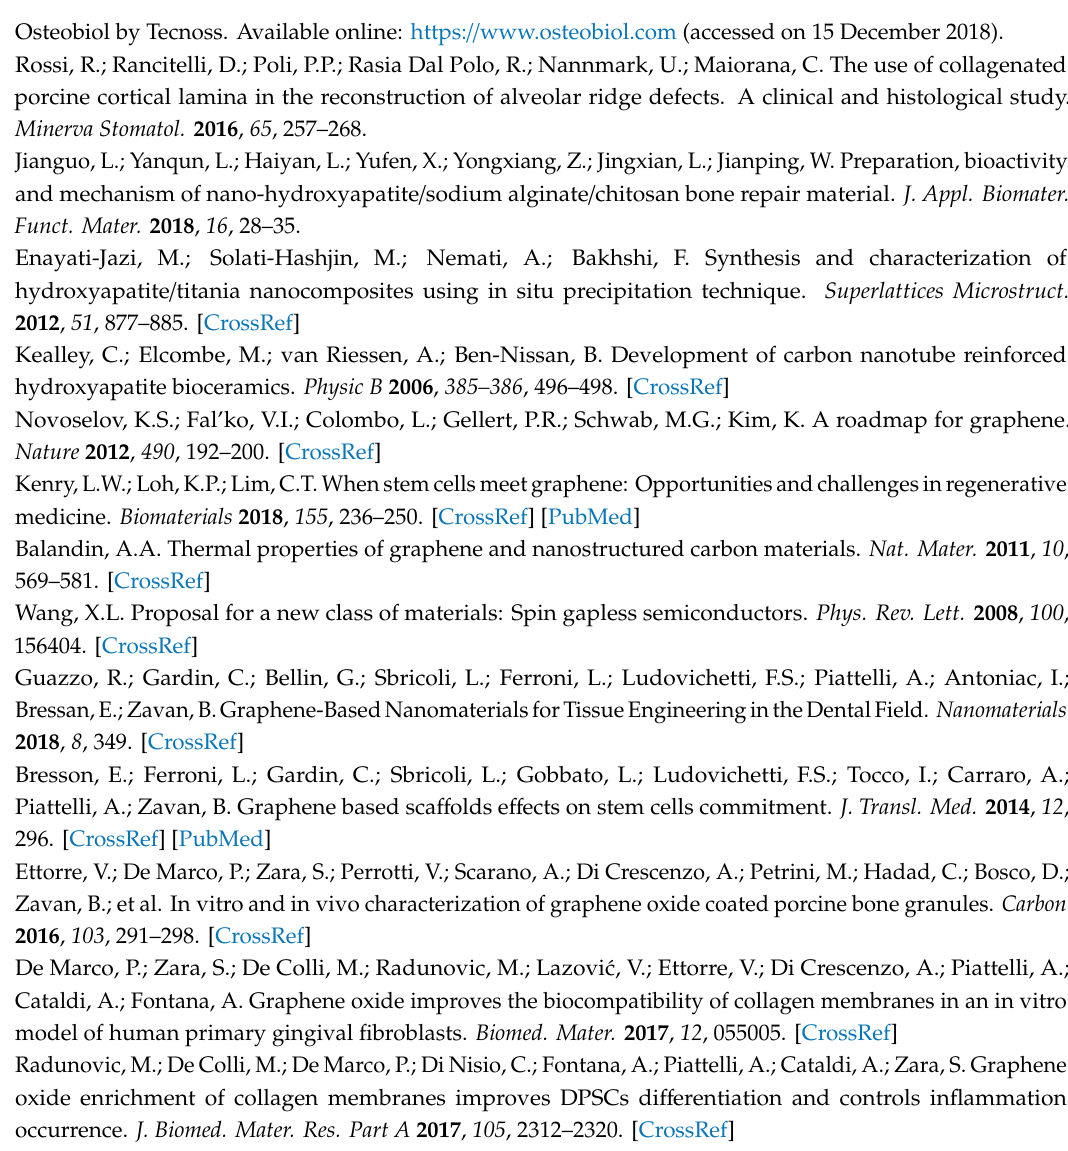
Figure S1: DPSCs observed with a light microscope before detachment and seeding for osteoblastic di ff erentiation, Figures S2–S7: Original AFM micrographs and representative force curves of pure Lamina, Lamina enriched with 5 µ g / mL GO and 10 µ g / mL GO used for the mechanical studies, Figures S8–S10: Original AFM micrographs used for the roughness index calculation of pure Lamina, Lamina enriched with 5 µ g / mL GO and 10 µ g / mL GO, Tables S1–S3: Roughness indexes for pure Lamina, Lamina enriched with 5 µ g / mL GO and 10 µ g / mL